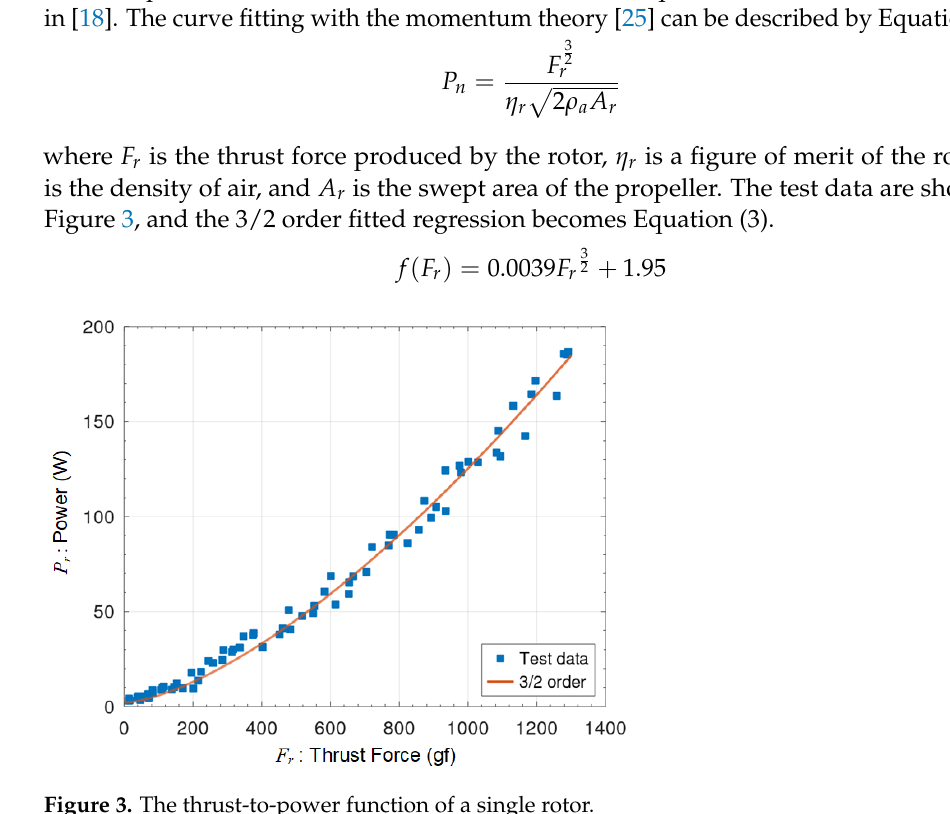
Figure 3. The thrust-to-power function of a single rotor.